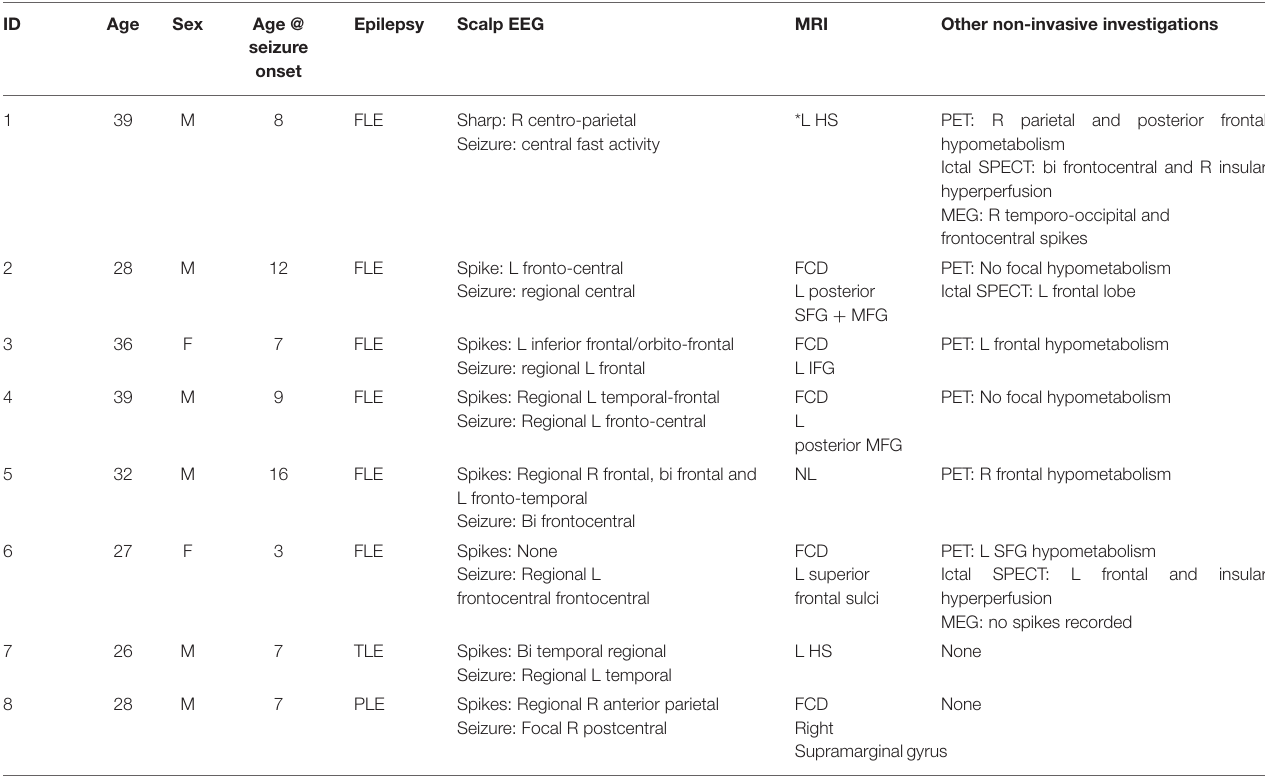
TABLE 1 | Clinical